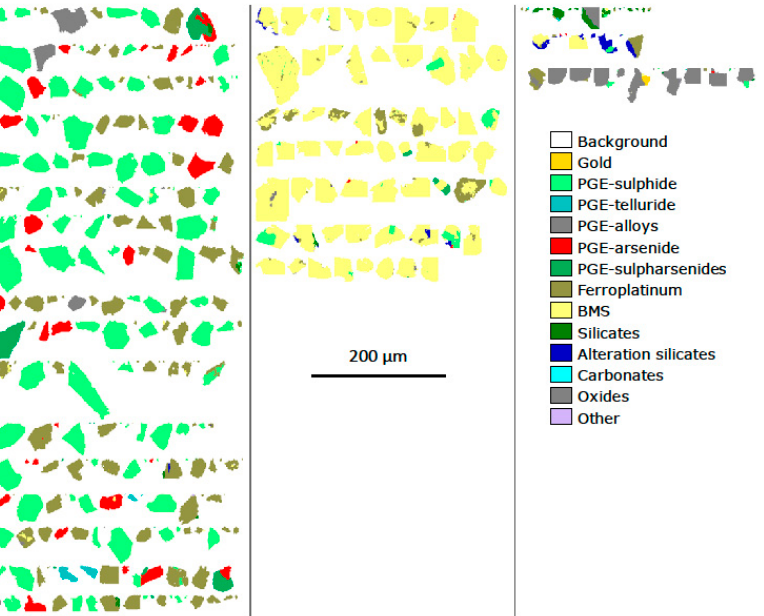
Figure 17. MLA false-color images of the various mineral particles in the nitric acid-washed concentrate. The first column shows the liberated platinum-group minerals, the second column some examples of sulphides and associated platinum-group minerals, and column 3 illustrates some of the silicate and oxide minerals (some still with associated sulphides).